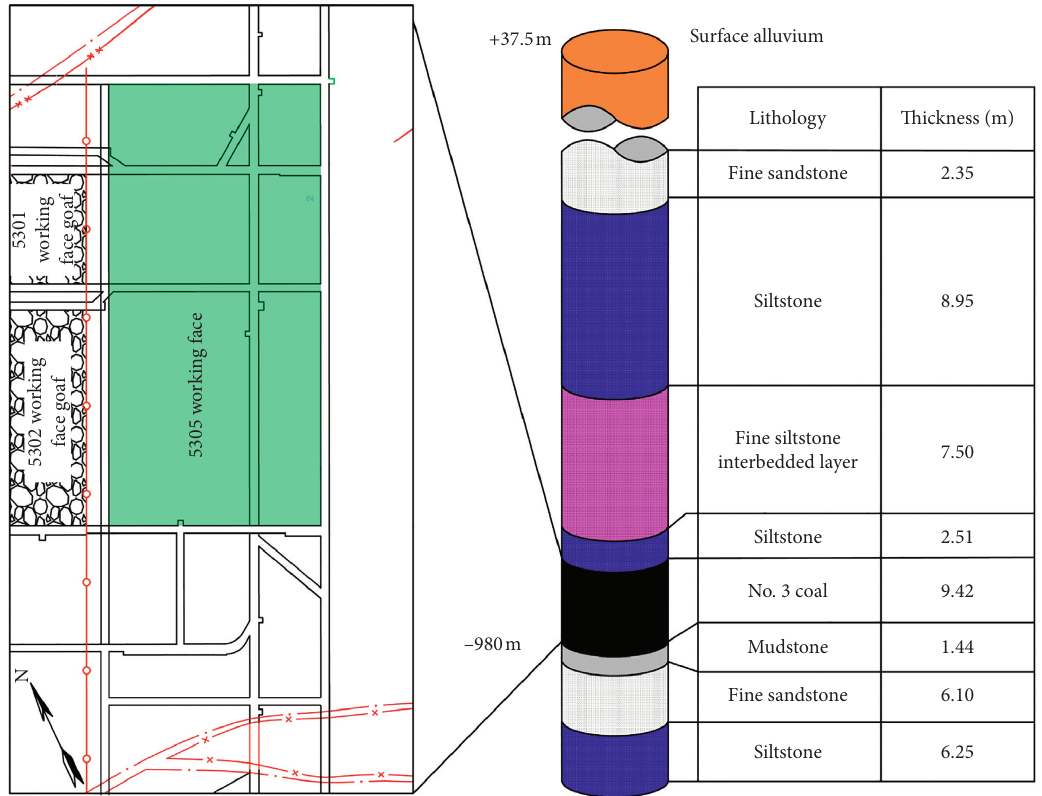
Figure 1: Layout of 5305 working face.